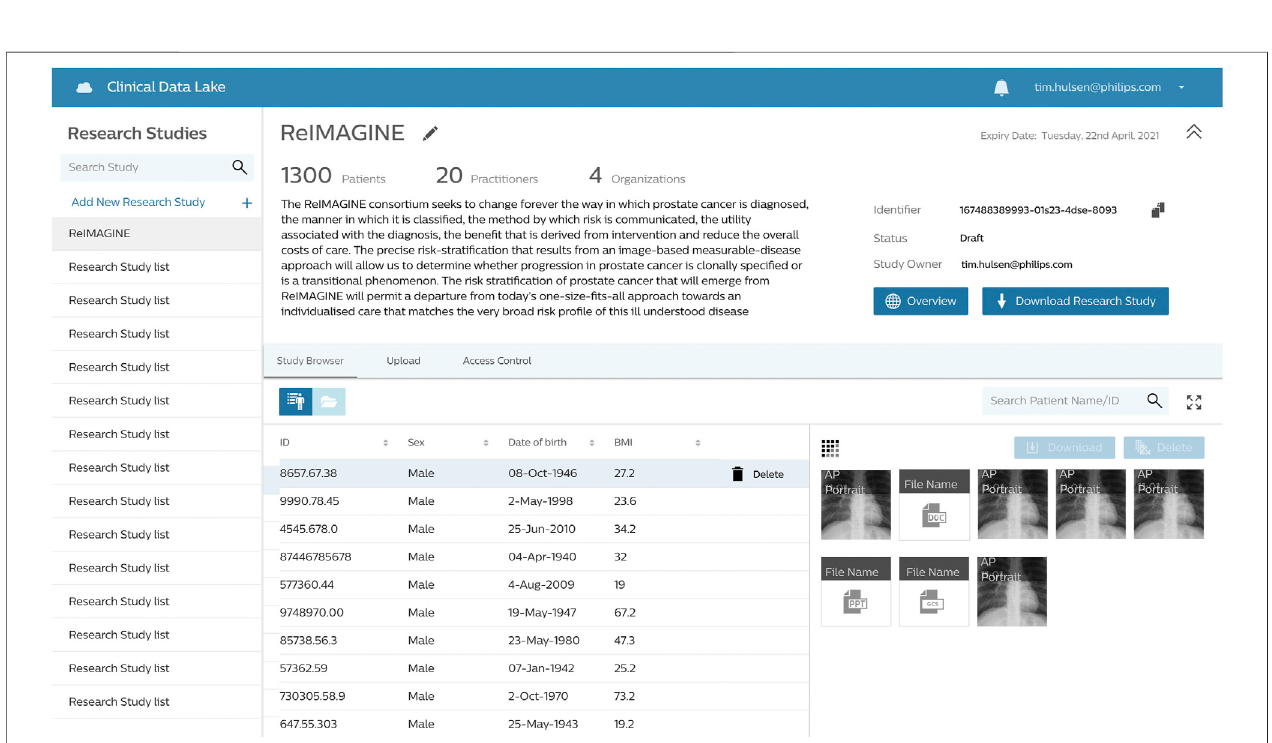
FIGURE 3 | The ReIMAGINE database in the CDL user interface. All data displayed is synthetic data.